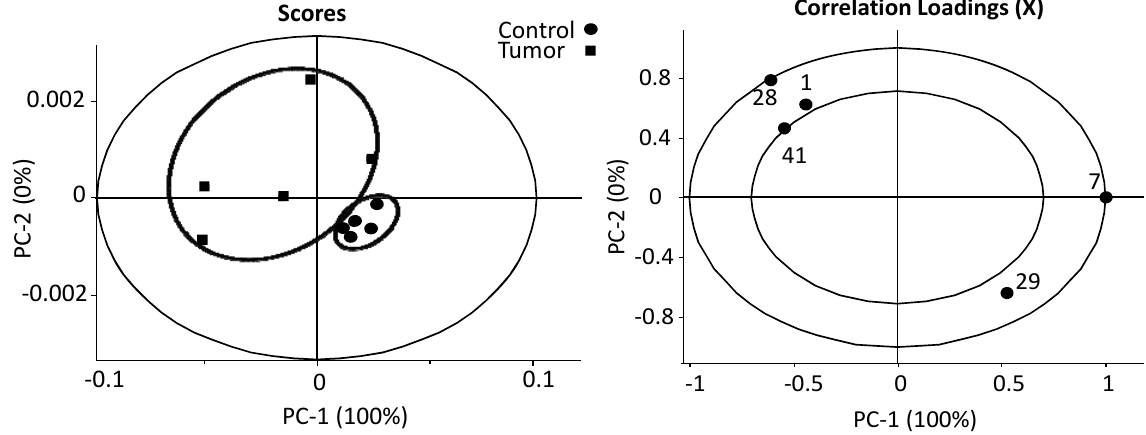
Figure 7. PCA analysis of important metabolites. Individual groups can be clustered into two groups from the first factor based on most changeable metabolites in melanoma, including both hydrophilic and hydrophobic metabolites. For secondary melanoma, the metabolites cholesterol (1), glutamate (28), fumarate (41) were increased with negative PC-1, and lipids (7) and succinate (28) and were decreased with positive